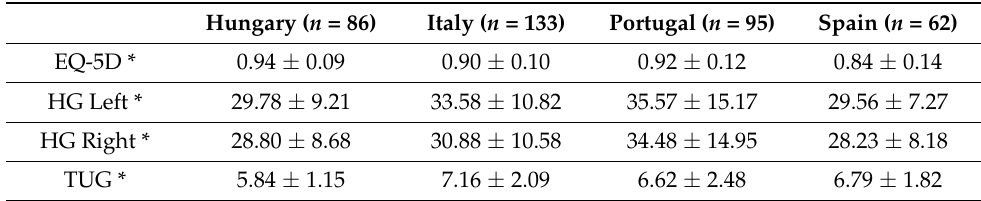
Table 4. Mean ± SD values of health perception (EQ-5D-5L), left (HG Left) and right (HG Right) grip strength, and the Timed Up and Go test (TUG) based on